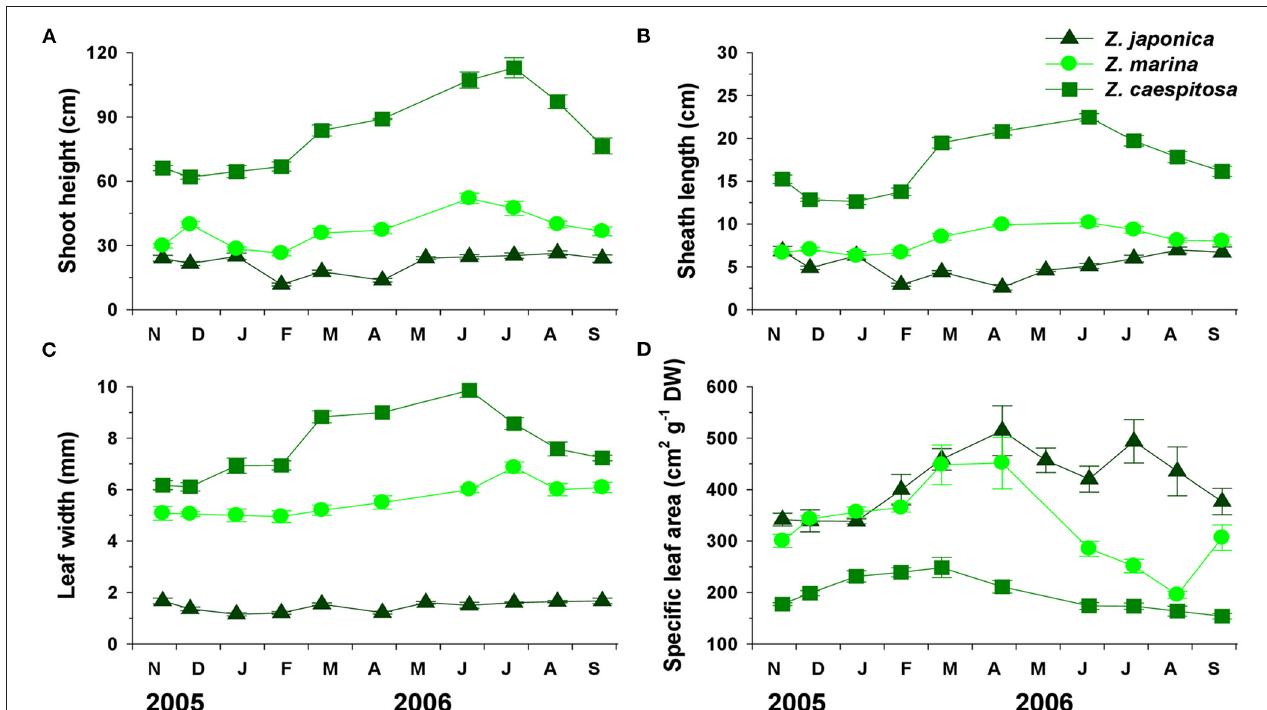
FIGURE 3 | Three Zostera species ( Z. japonica , Z. marina , and Z. caespitosa ). Seasonal changes in shoot height (A) , sheath length (B) , leaf width (C) , and specific leaf area (D) in Koje Bay. Values are expressed as mean ± SE ( n = 10–15).